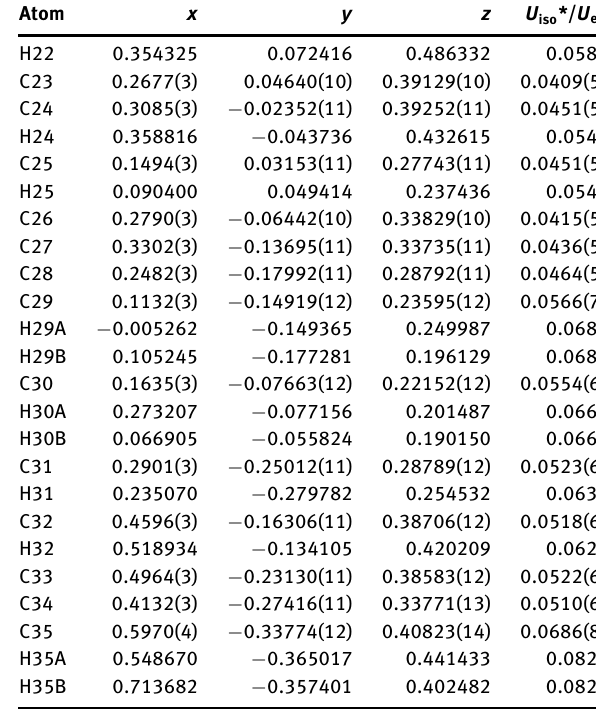
Table 2: Fractional atomic coordinates and isotropic or equivalent isotropic displacement parameters (Å 2